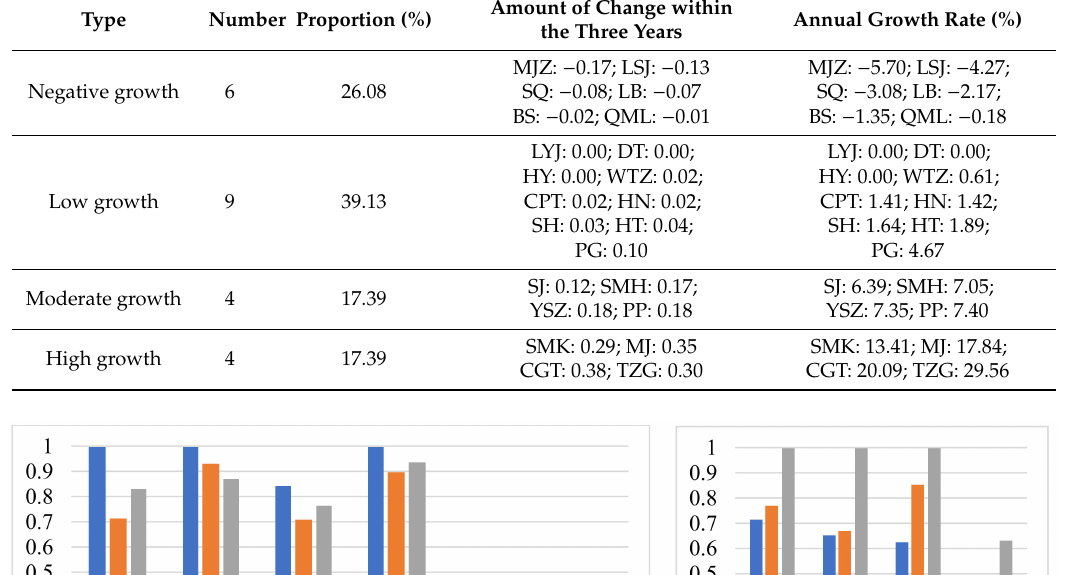
Table 2. The growth type of villages in Pupiao Town.